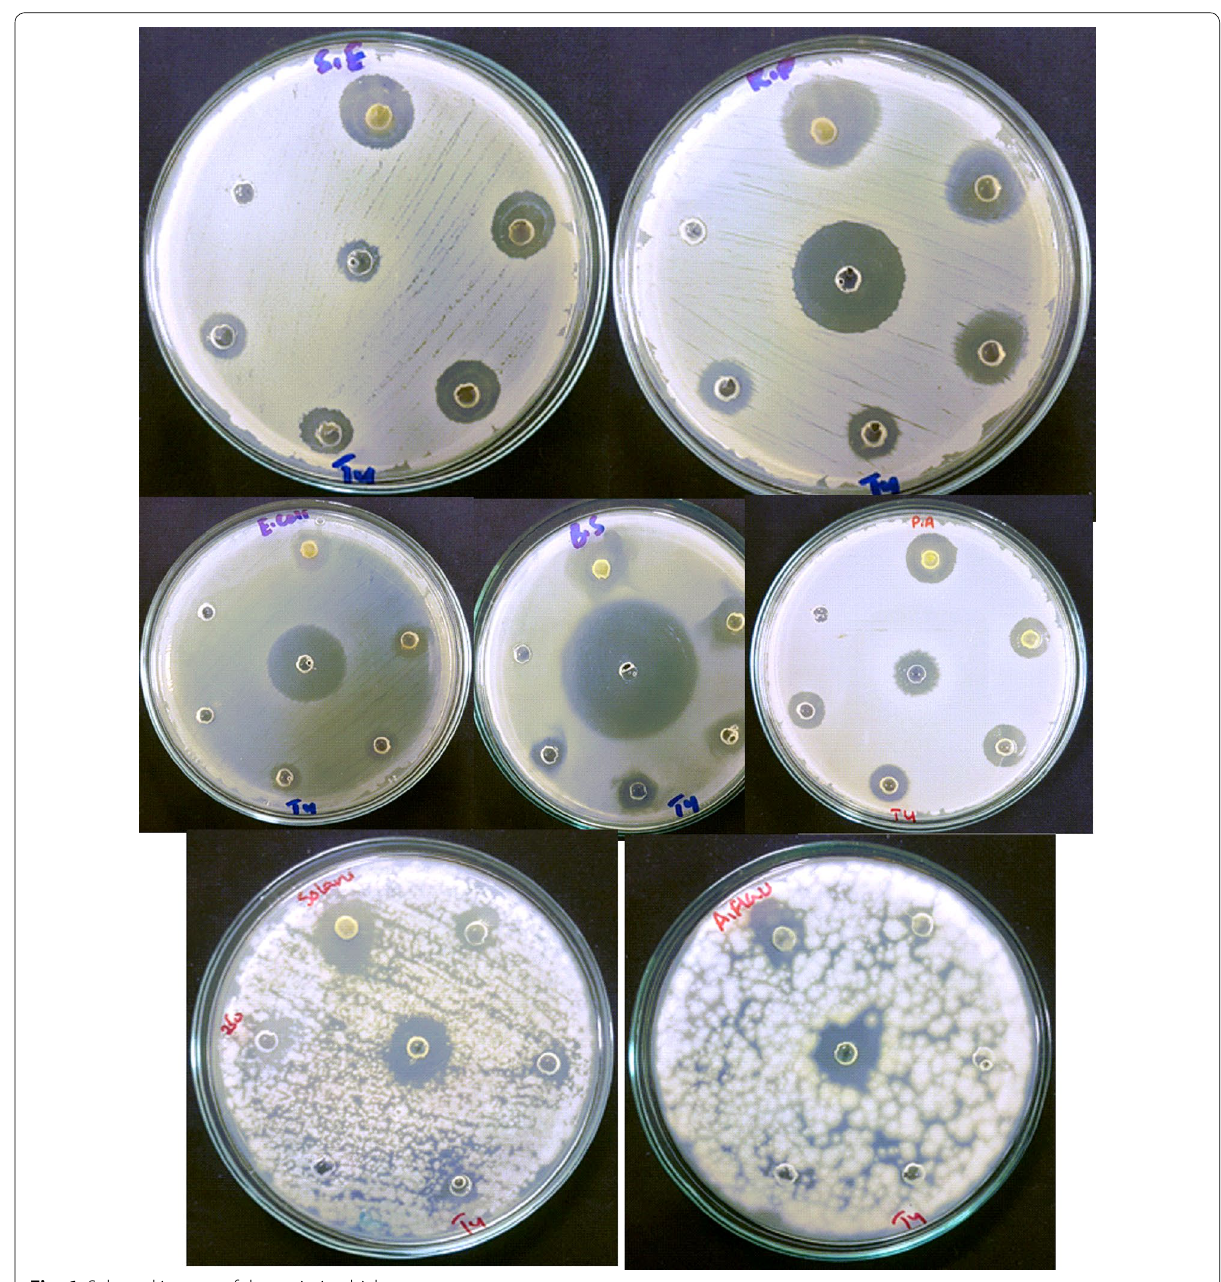
Fig. 6 Selected images of the antimicrobial